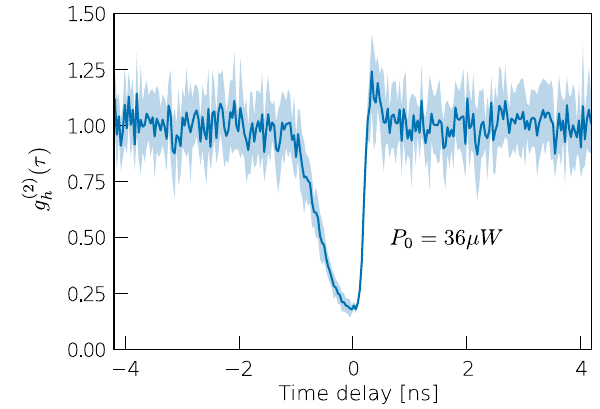
Fig. 4 Heralded single-photon emission. Heralded second-order ð 0 Þ ¼ 0 : 17 ± 0 : 02; measured at pump correlation function showing a g ð 2 Þ h power in the cavity P 0 = 36 μ W. The shaded region corresponds to 1